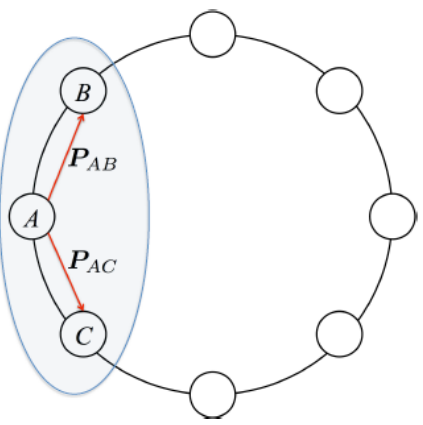
Fig. 2. Local shape information of the ant agent on A